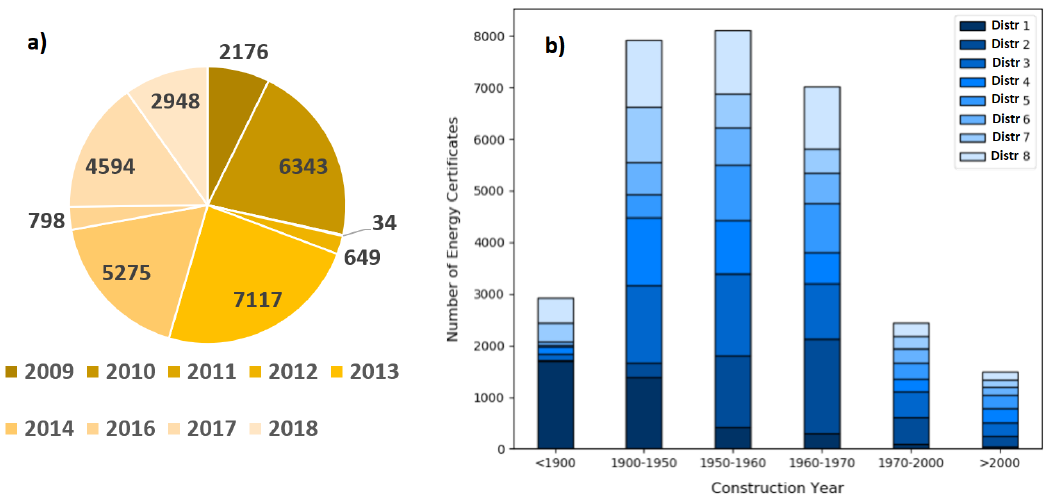
Figure 8. Basic statistic distributions after data